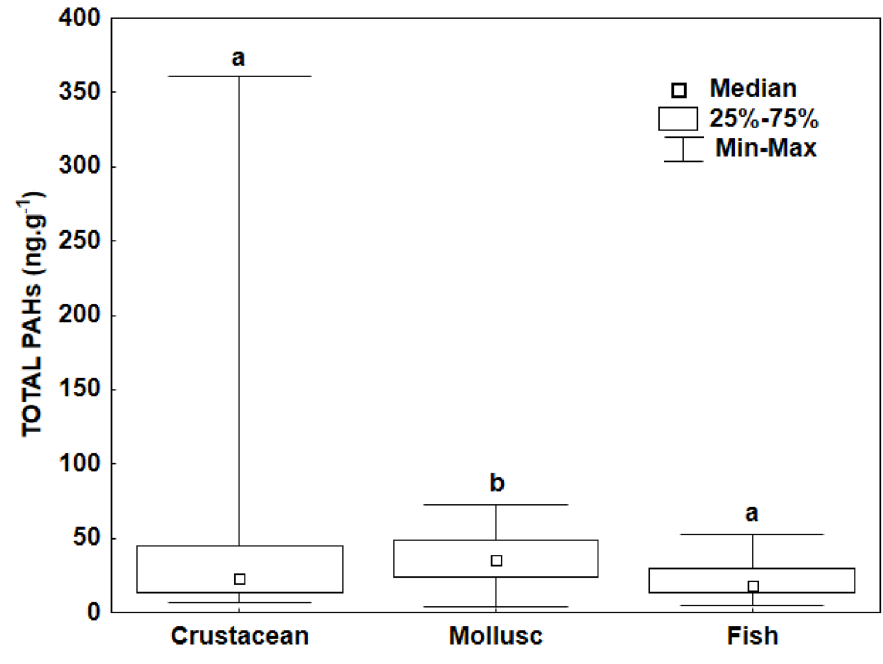
Figure 4. Comparison of PAH concentrations determined in organisms collected in the Canavieiras region after the 2019 oil spill in